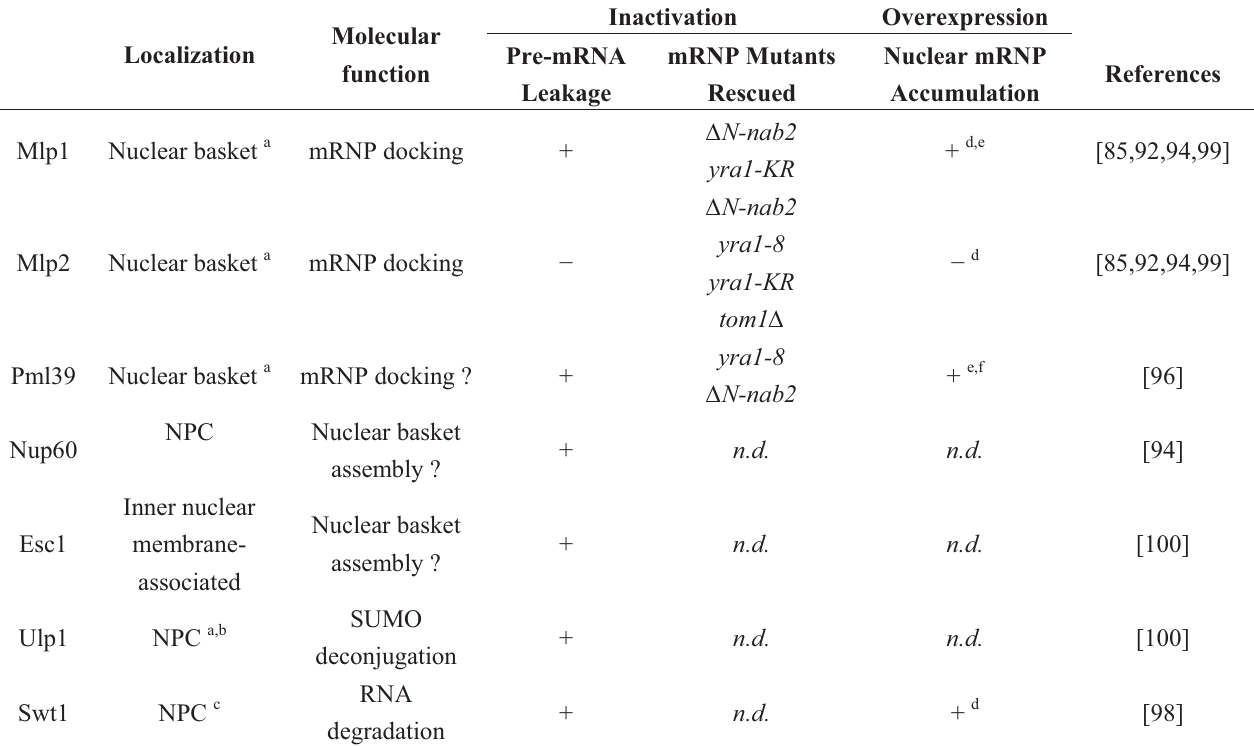
Table 2. NPC-associated proteins involved in mRNA QC prior to export in yeast. The proteins identified as contributing to mRNA QC in yeast are presented. QC phenotypes arising upon inactivation or overexpression of the protein are listed. The detection of leakage phenotypes with the LacZ-based reporter system (“pre-mRNA leakage”, (+)), as well as the names of the mRNP mutants that are rescued upon inactivation of the protein, are